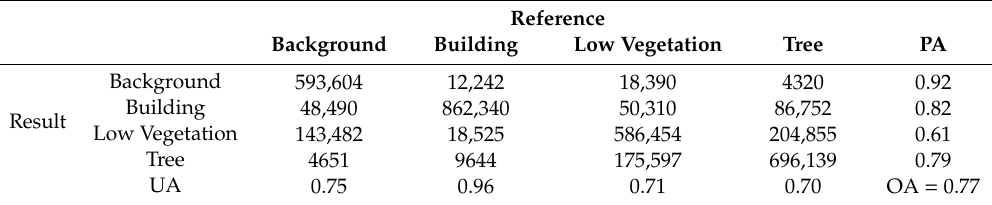
Figure 3. Results of Vahingen Dataset. ( a ) Coarse image; ( b ) SASPM result; ( c ) VBSPM result; ( d ) SRM CNN result; and ( e ) reference map. The second and third row were zoom-in areas from the first row. Table 4. Confusion matrix of SASPM result for Vahingen Dataset.